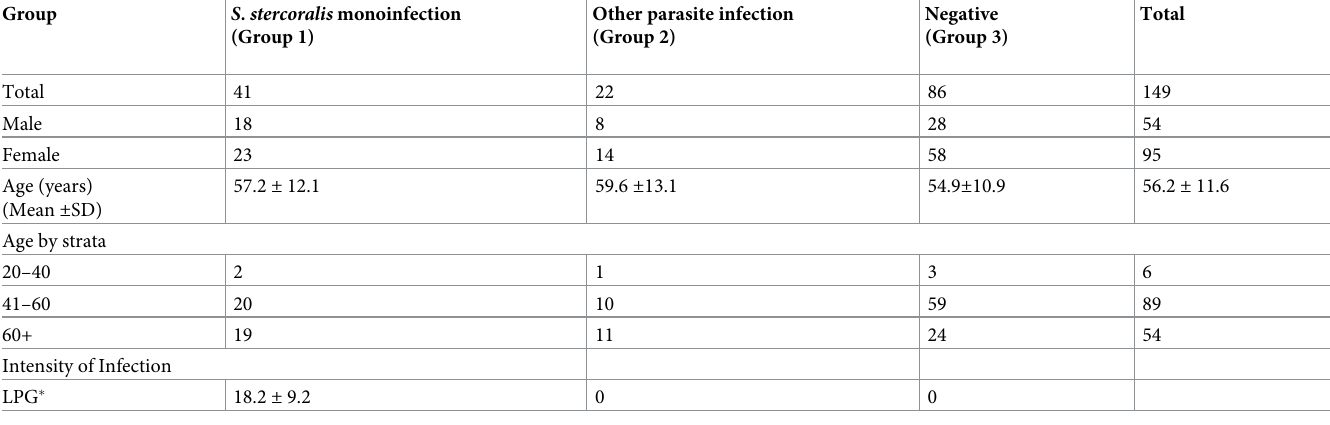
Table 1. Demographic data and detail parasitic infections of the field collected sample subjects for assessment of diagnosis performance study. Data shown were number of subjects, mean and S.D.